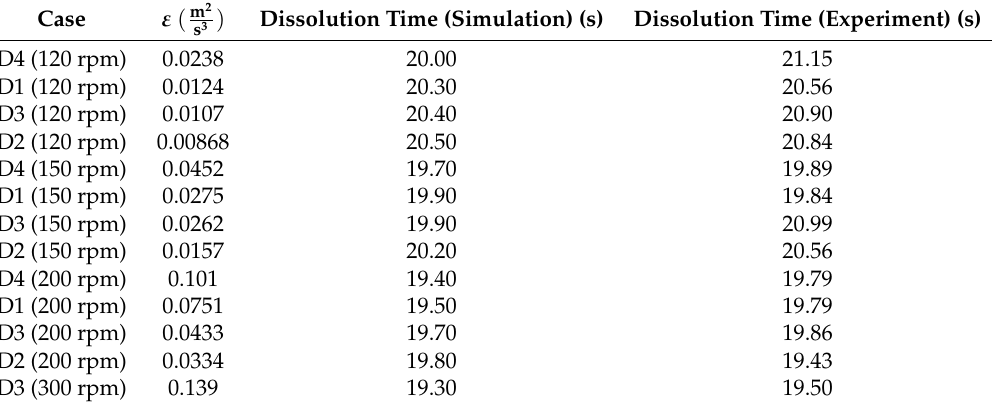
Table 3. Comparison of simulated and experimentally determined dissolution times and dissipation rates of turbulent kinetic energy.